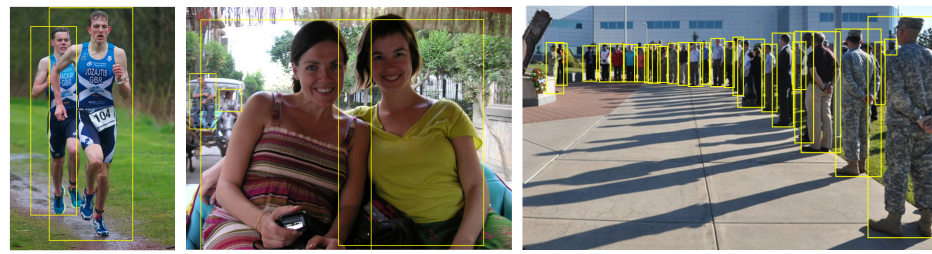
Figure 9. Examples of annotated images in Open Images